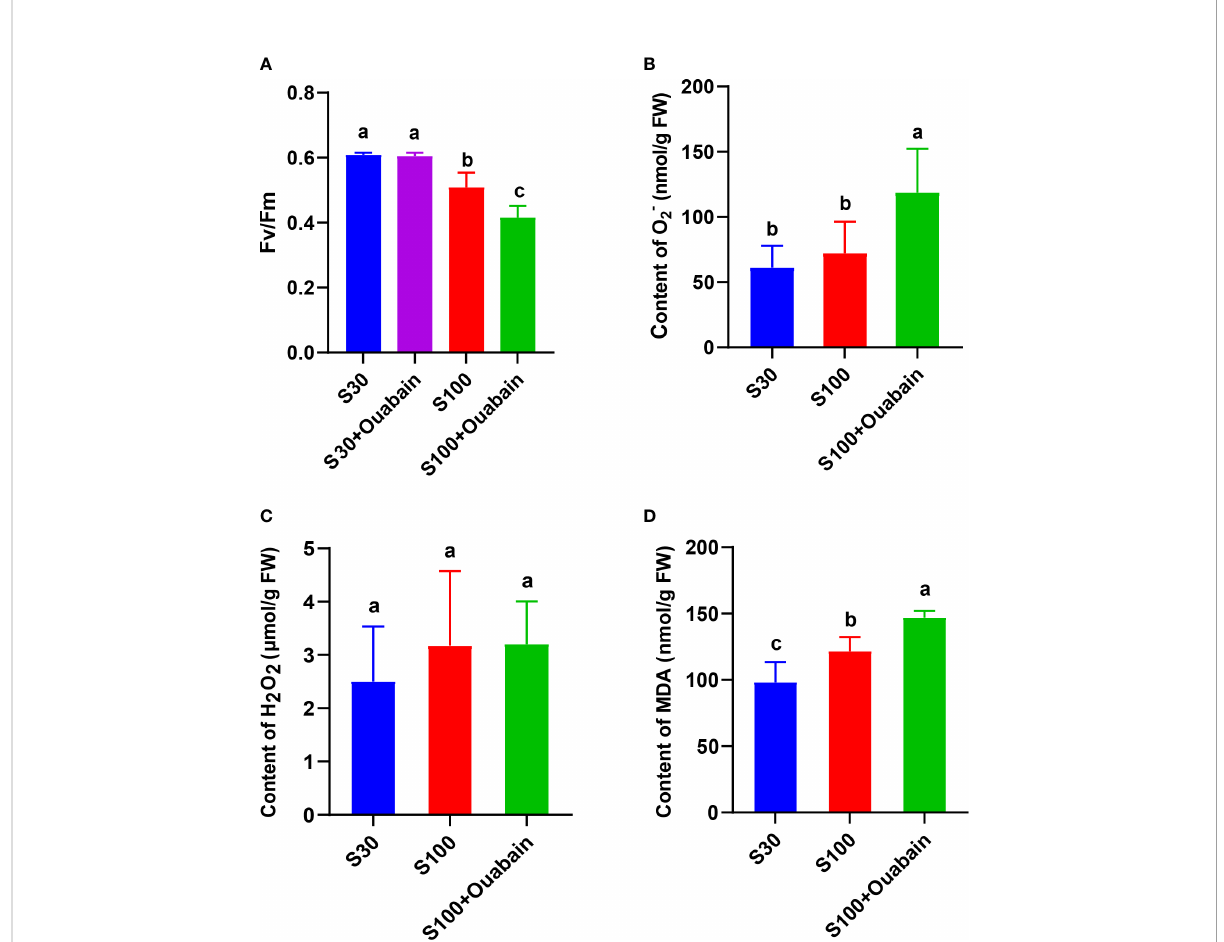
FIGURE 2 Effects of hypersaline stress (100 ‰ , 15 min) and ouabain on physiological indexes of N. haitanensis. (A) Variations in photosynthetic parameters and optimum quantum yield (F v /F m ) of N. haitanensis under hypersaline stress and in the presence of ouabain. O 2 − content (B) , H 2 O 2 content (C) and MDA content (D) of N. haitanensis under hypersaline stress and in the presence of ouabain. FW: fresh weight of thalli. S30: control salinity (30 ‰ ). S100: hypersaline stress (100 ‰ ). Values shown are the mean of three thalli. Bars represent the standard error of the mean ( n = 3). Different letters indicate signi fi cant differences among treatments ( P<